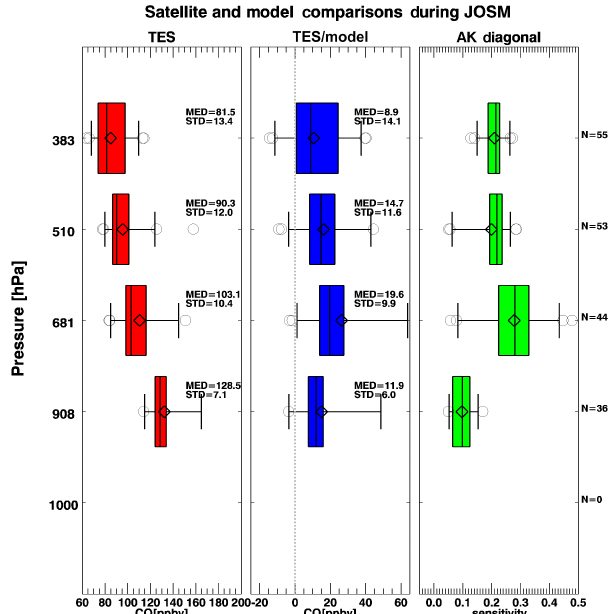
Figure 13. Single CO profile GEM-MACH model/satellite compar- ison and associated plots. (a) follows the same convention as Fig. 3, with the model profile replacing the aircraft profile. (b) contains the difference between the TES-retrieved profile (purple) and the model profile (red). (c) contains the rows of the satellite averaging kernels at each retrieval level. (d) shows the 2-D simulated NH3 model field at 962hPa that corresponds most closely to the TES overpass at 13:30LST on 3 September 2013. The profiles being compared are for the locations outlined in magenta, with the larger box showing the TES footprint and the smaller inner box the model grid box.